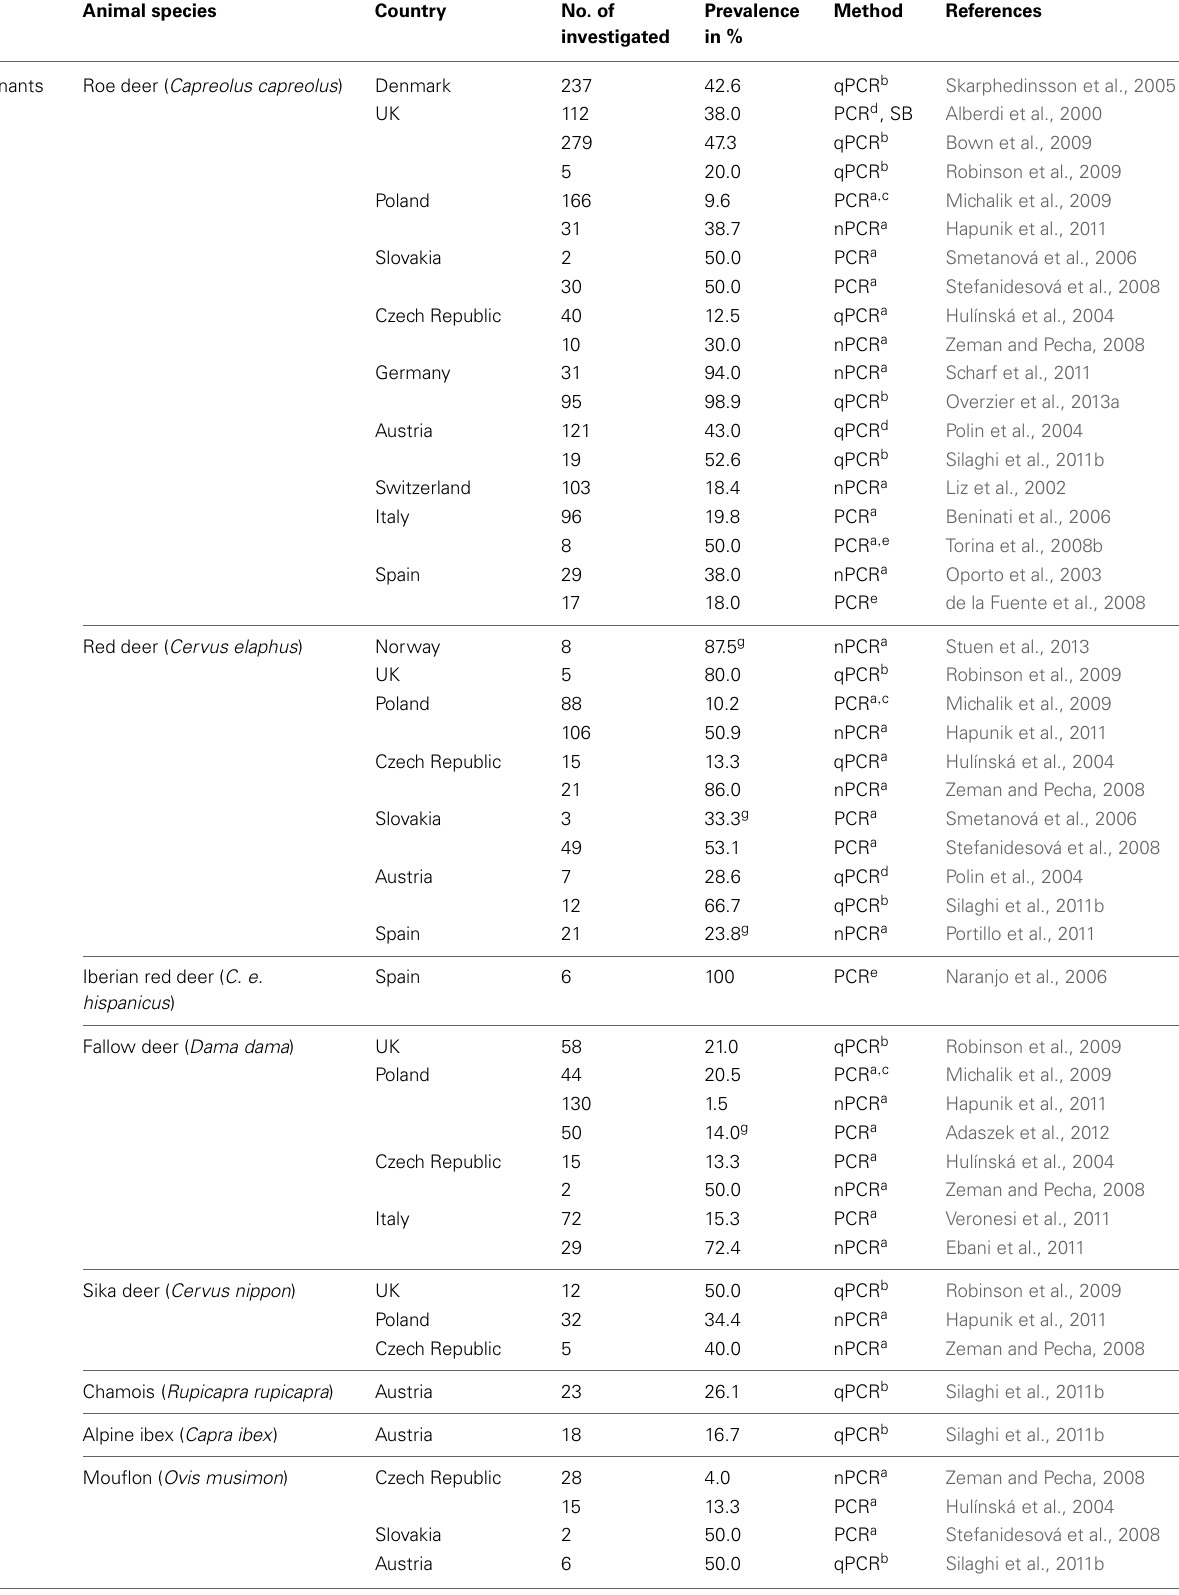
Table 7 | Detection of DNA of Anaplasma phagocytophilum in blood or tissue (majority spleen) of vertebrate hosts in Europe*. Group of animals